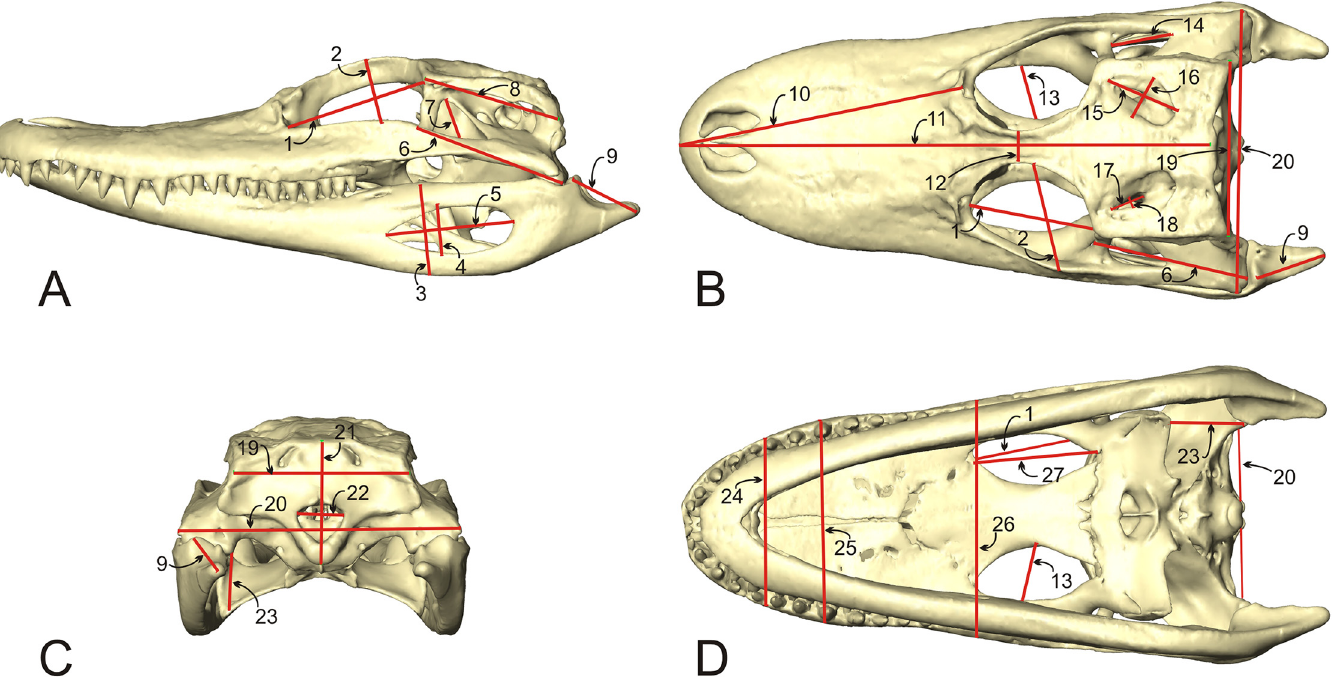
Fig 3. Skull measurements used to calculate Geometric Mean of skull size in Alligator mississippiensis , shown in A) left lateral, B) dorsal, C) caudal, and D) ventral views. Linear measurements taken of the following: 1. Orbit length; 2. Orbit width; 3. Mandible height; 4. Mandibular fenestra height; 5. Mandibular fenestra length; 6. Post-orbital skull length; 7. Infratemporal fossa width; 8. Braincase length; 9. Retroarticular process length; 10. Rostrum length; 11. Dorsal skull length; 12. Interorbital width; 13. Palatal foramen width; 14. Infratemporal fossa width; 15. Supratemporal fossa maximum length; 16. Supratemporal fossa minimum width; 17. Supratemporal foramen length; 18. Supratemporal fenestra width; 19. Braincase width; 20. Skull width at quadrates; 21. Braincase height; 22. Foramen magnum width; 23. Pterygoid height; 24. Rostrum width at 2 nd maxillary alveolus; 25. Rostrum width at 4 th maxillary alveolus; 26. Rostrum width at anterior edge of palatine fenestra; 27. Palatal fossa length.